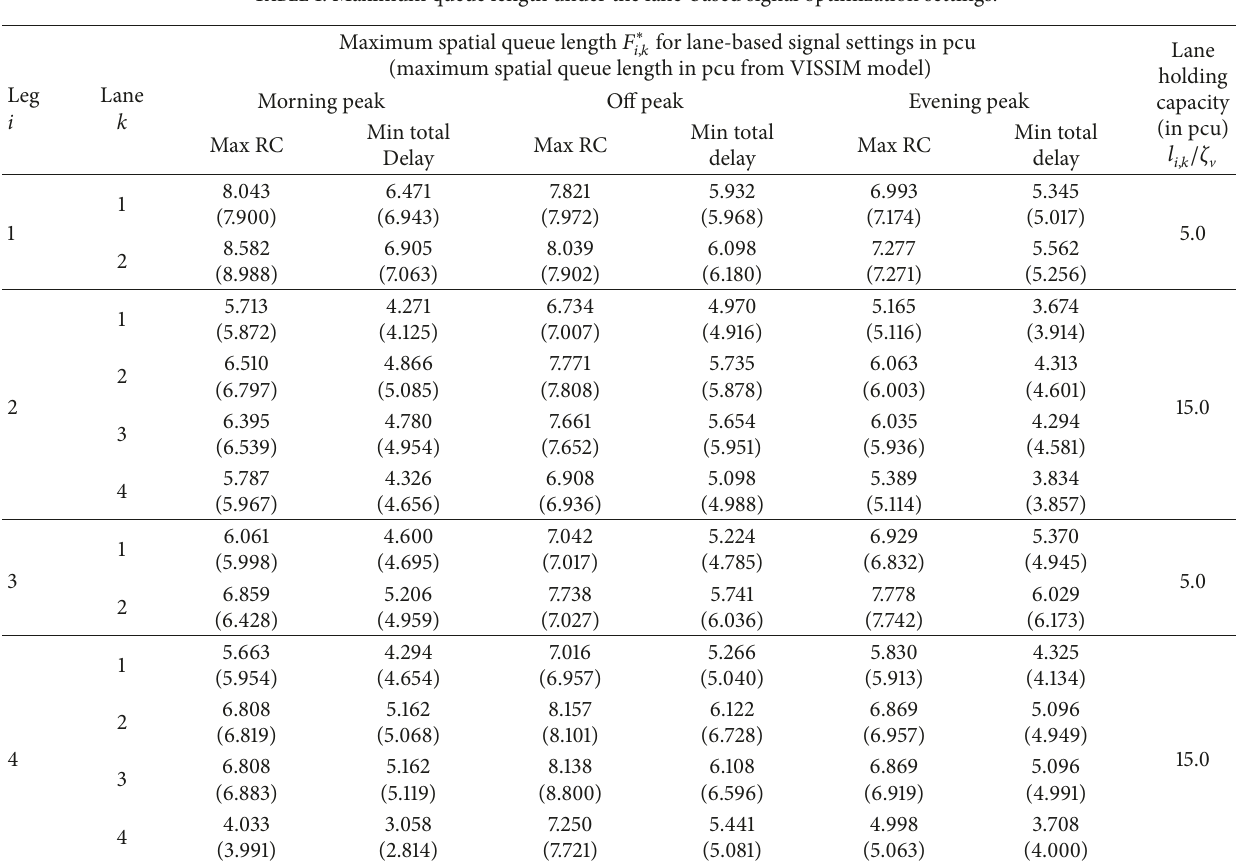
Table 1: Maximum queue length under the lane-based signal optimization settings.